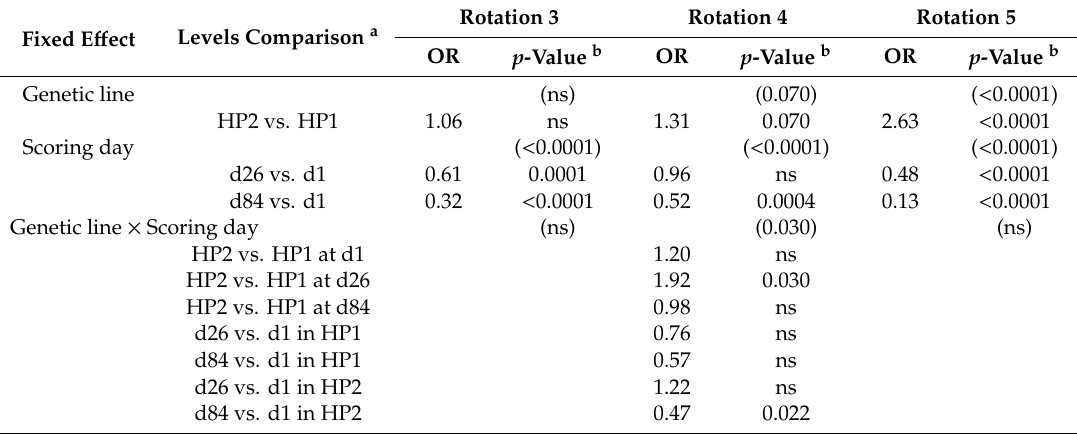
Table 3. Summary of the impact of genetic line (HP2 vs. HP1), scoring day (d1, d26, and d84) and their interaction on MIDDLE body lesion scores within each rotation (3, 4, and